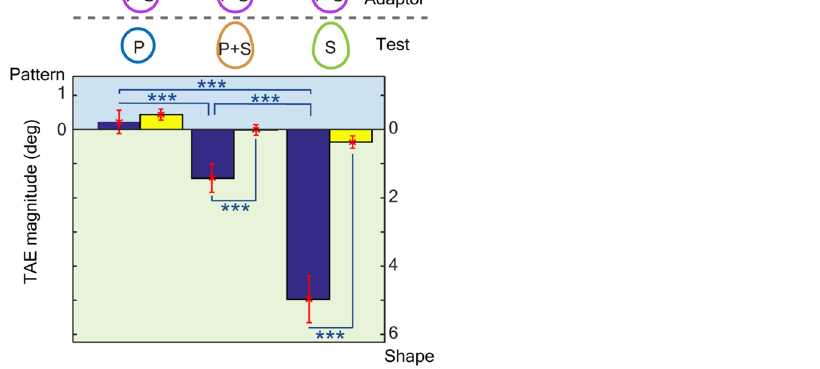
Figure 4. The mean TAE magnitudes across the participants with incongruent, antagonistic adaptors (Exp. 2). The same conventions are used as in Fig. 2. Blue and yellow bars show the measured TAEs for the three conditions (from the left, TAE P–S,P , TAE P–S,P+S , and TAE P–S,S ) and those for the corresponding blank conditions, respectively. The TAE for SP is plotted toward the positive direction in the ordinate (the scale on the left), whereas the TAE for SS is plotted toward the negative direction (the scale on the right). Error bars show the standard error (SEM), and asterisks denote statistical significance (*p < 0.05; **p < 0.01; ***p <